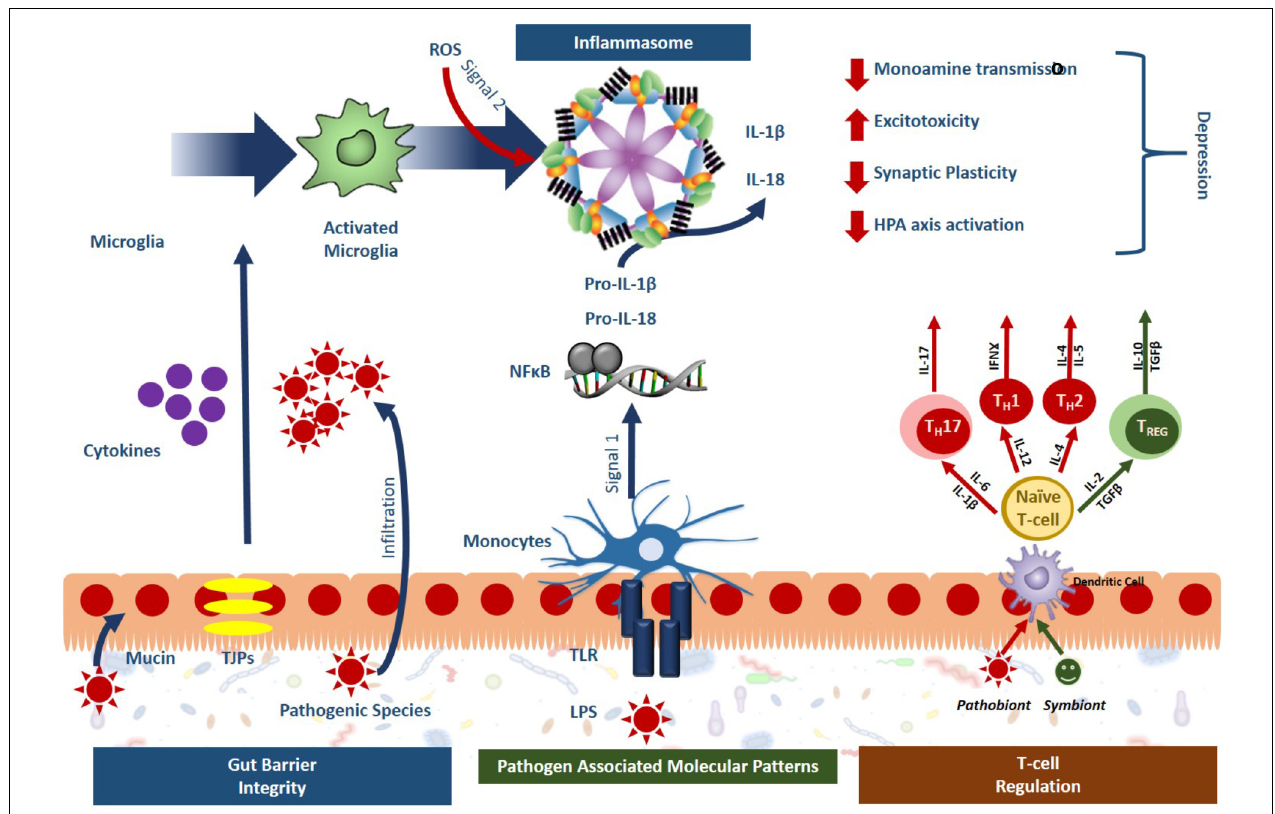
FIGURE 2 | Gut microbiota activated inflammasome signaling leads to phenotypes specific to depression. Sterile inflammatory responses involving inflammasome signaling is a key mechanism of stress-induced depression and the gut microbiota has been shown to impact inflammasome signaling at several levels. Symbionts, or beneficial bacteria, have been shown to promote gut barrier integrity, and guide T-cell regulation toward an anti-inflammatory phenotype (green). Pathobionts, or bacteria with a negative effect, have the opposite effect, compromising the gut barrier integrity, activating immune response through the release of pathogen associated molecular patterns (PAMPs) and pushing T cell development toward a proinflammatory state (red). Overall, these effects lead to inflammasome activation in the periphery and the microglia that ultimately promote the development of